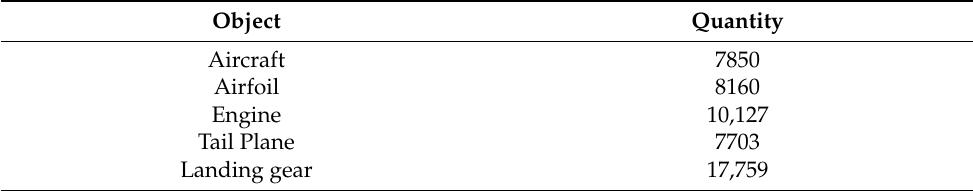
Table 1. Statistics of the annotations (Number of five categories of